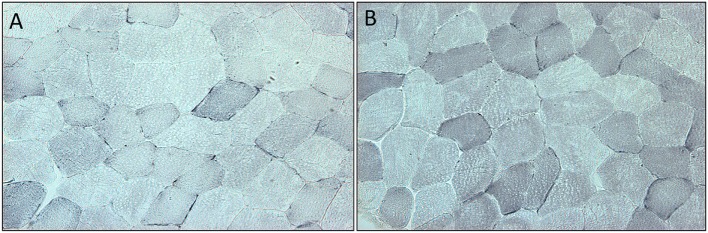
(A) Section of quadriceps muscle from a patient deficient in growth hormone at the start of the trial. Blue staining denotes the mitochondrial enzyme succinate dehydrogenase. (B) Section of quadriceps muscle from the same patient at the end of the trial after 3 months treatment with growth hormone. Staining as above.